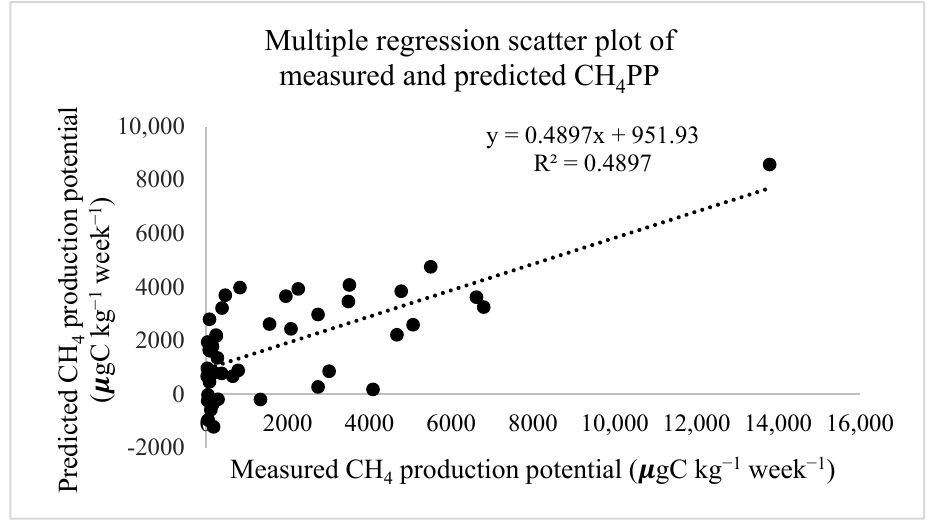
Figure 6. Multiple regression scatter plot between CH 4 production potential (CH 4 PP) and major soil properties before incubation. Table 2. Correlation matrix among CH 4 Production Potential (CH 4 PP) and soil properties (after incubation).